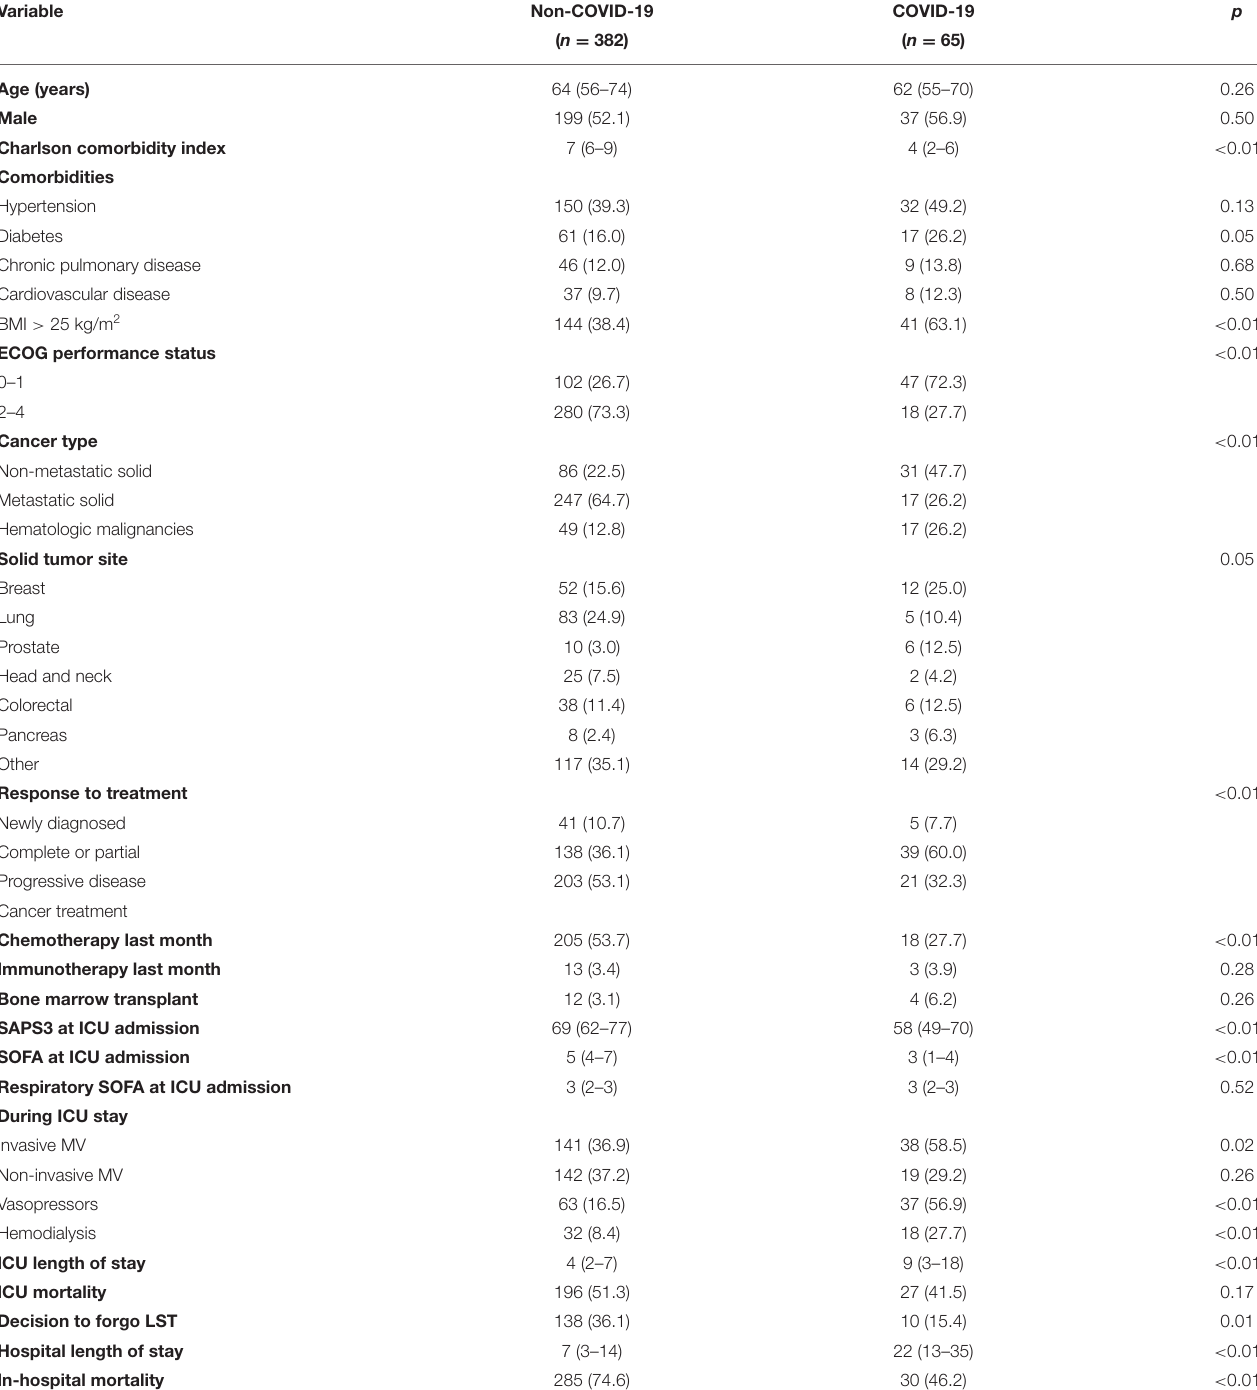
TABLE 1 | Characteristics of patients with cancer and acute respiratory failure due to COVID-19 and non-COVID-19 causes.